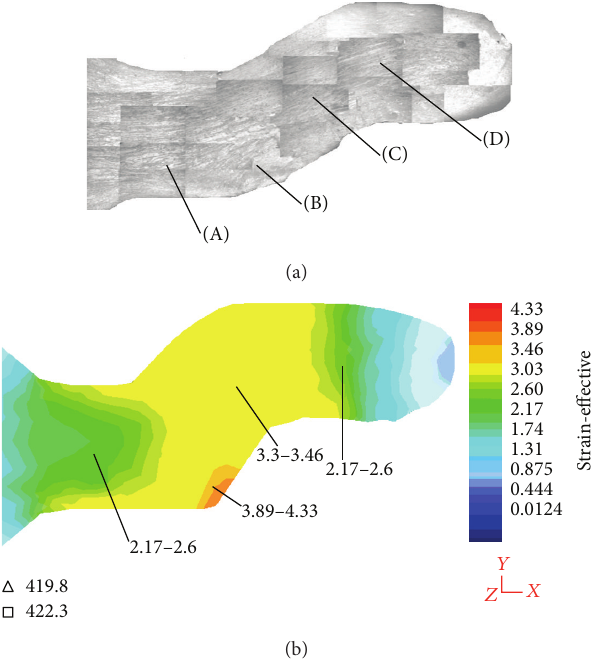
Figure 9: Final microstructure of the extrudate at 420 ∘ C and strain distribution diagram obtained from